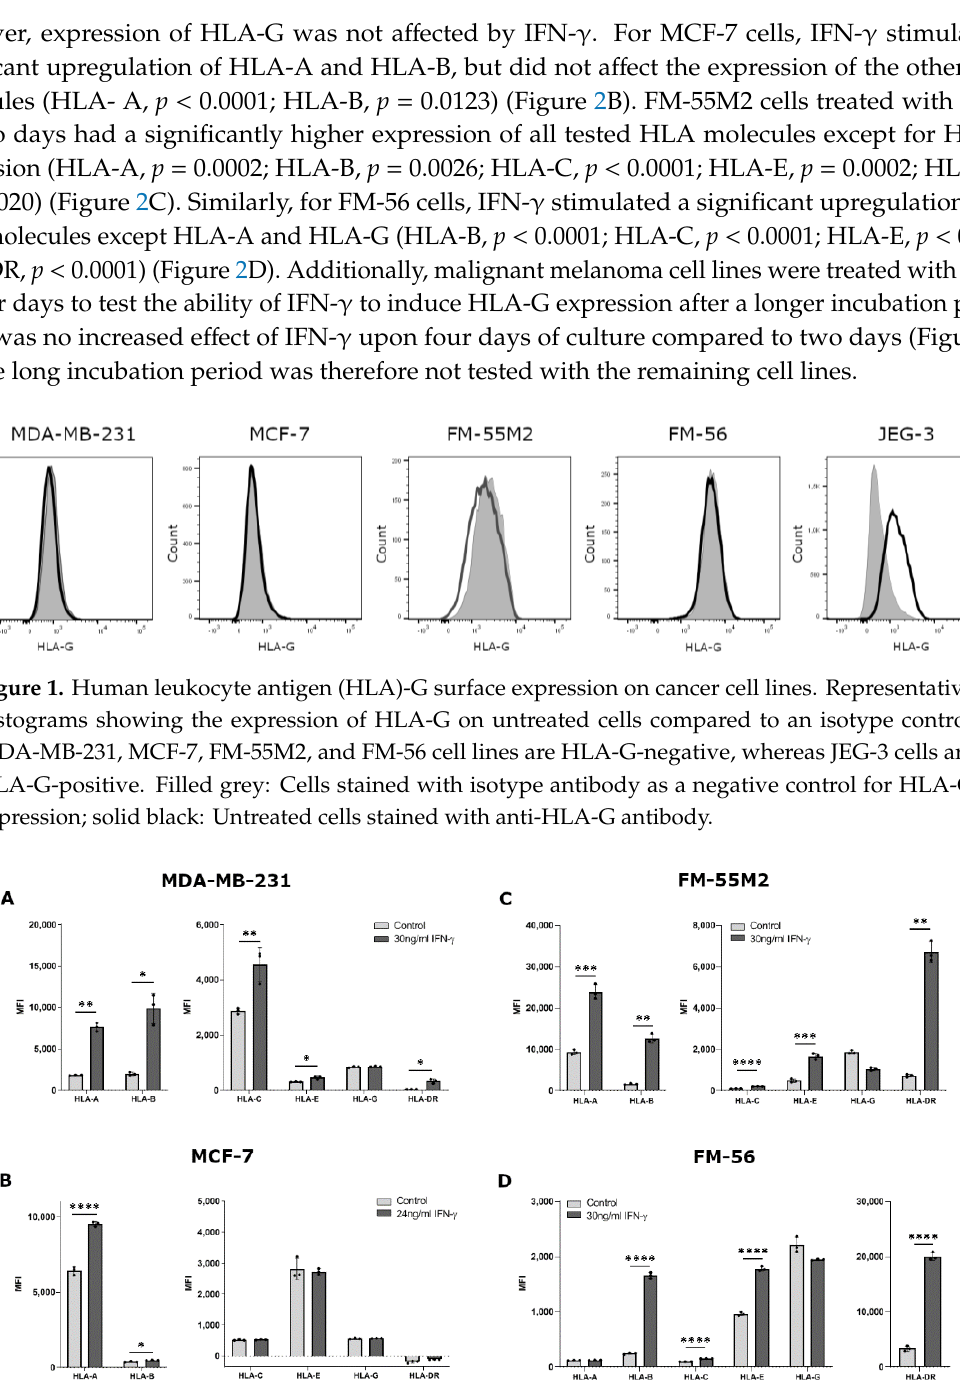
Figure2. HLAsurfaceexpressiononcancercelllinesstimulatedwithinterferon(IFN)- γ . Flowcytometry analysis of HLA-A, HLA-B, HLA-C, HLA-G, HLA-E, and HLA-DR expression. ( A ) MDA-MB-231 cells treated with 30 ng / mL IFN- γ for two days. ( B ) MCF-7 cells treated with 24 ng / mL IFN- γ for two days. ( C ) FM-55M2 cells treated with 30 ng / mL IFN- γ for two days. ( D ) FM-56 cells treated with 30 ng / mL IFN- γ for two days. Shown are median fluorescence intensity (MFI) with mean ± SD, each dot represents one sample. All cell lines are HLA-G-negative and the shown MFI level of control samples represent the background. * p < 0.05, ** p < 0.01, *** p < 0.001, **** p < 0.0001 (Student’s unpaired t -test with Welch’s